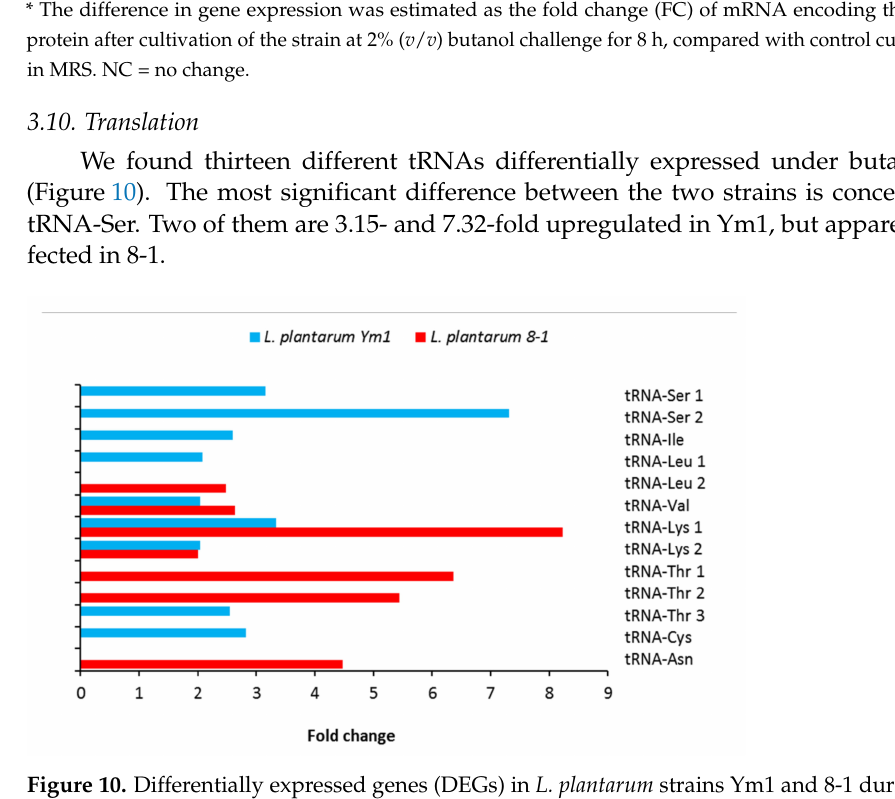
Figure 10. Differentially expressed genes (DEGs) in L. plantarum strains Ym1 and 8-1 during butanol stress encoding transport RNAs. Gene and tRNA: lp_tRNA50, tRNA-Ser 1; lp_tRNA25, tRNA-Ser